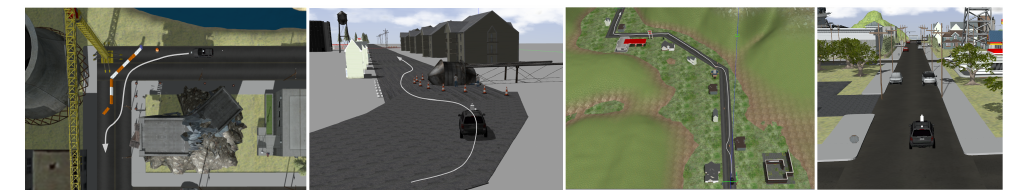
Figure 6. ROS simulated environments.